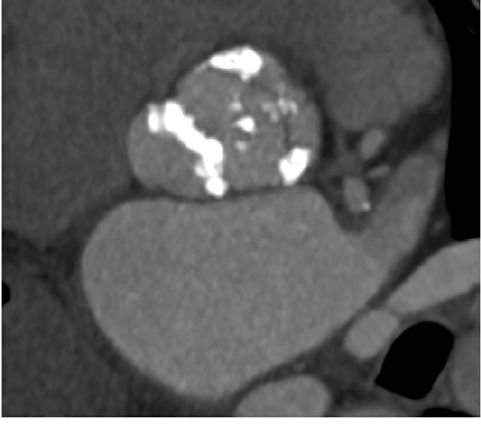
Figure 4. Aortic valve leaflet, annulus and root calcification on